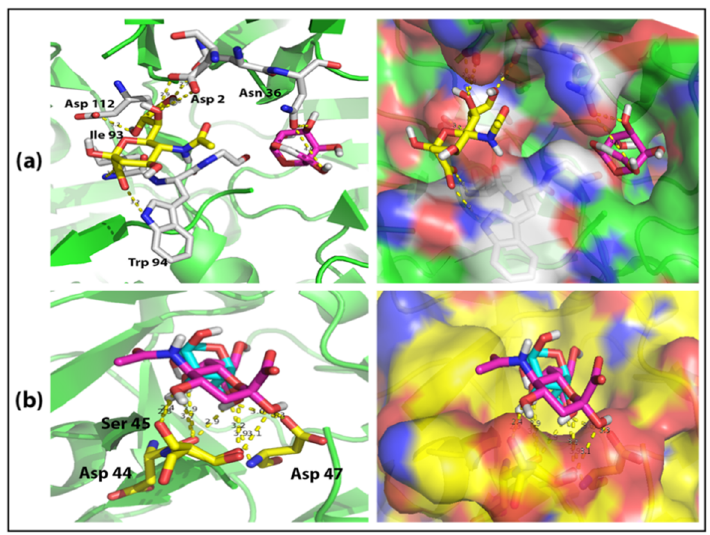
Figure 2. Binding poses of virtual docking. ( a ) MLB + Neu5Ac and β -Galactose; ( b ) SNA-B + Neu5Ac and β -Galactose.